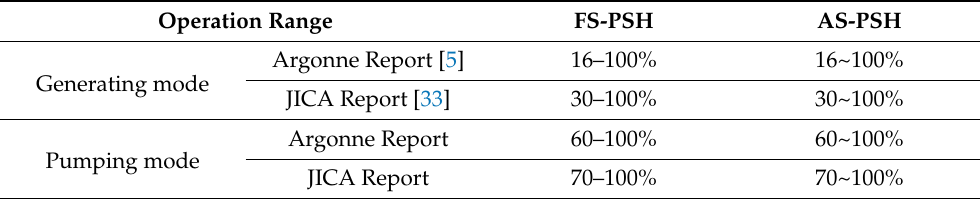
Table 4. Example of pumped-storage hydropower (PSH) operation